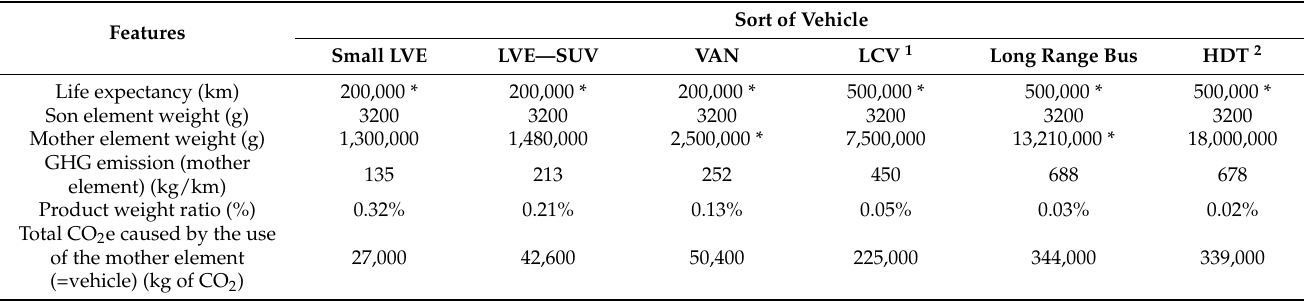
Table 35. Main features of the analyzed product that are necessary to calculate the CF of the product once assembled and used in the final assembly/vehicle